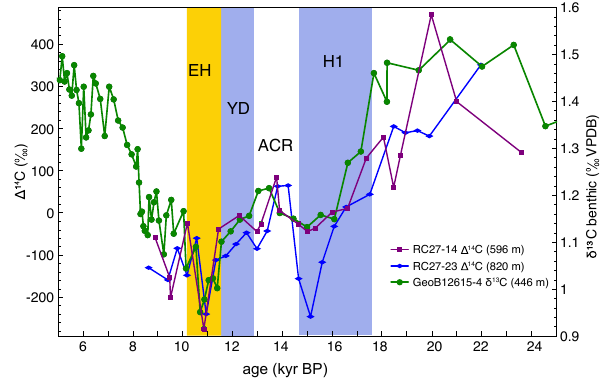
Fig. 4. Comparison of GeoB12615-4 and sediment records from the Arabian Sea. GeoB12615-4: δ 13 C benthic record (‰ VPDB; green). Arabian Sea RC27-14 and RC27-23 (Bryan et al., 2010): interme- diate water 1 14 C as a measure for ventilation